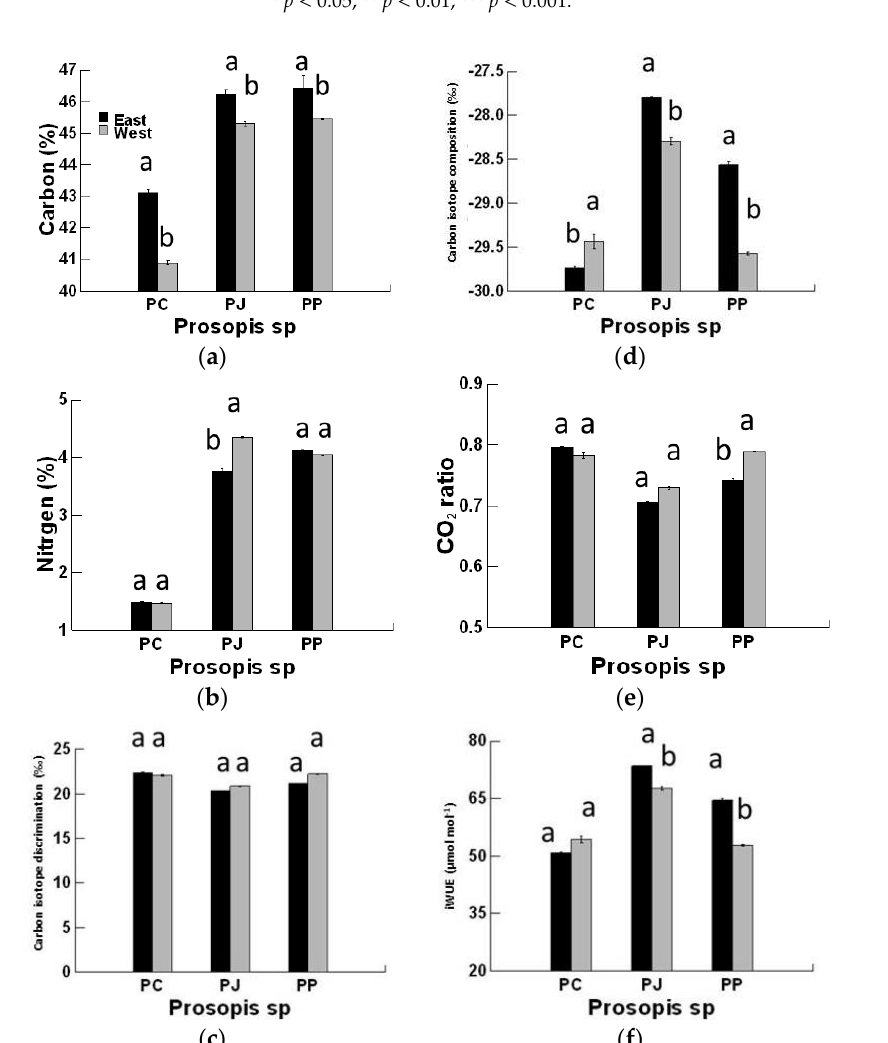
Figure 3. Effects of Prosopis species ( Prosopis juliflora , Prosopis pallida , and Prosopis cineraria ) canopy position (east and west) on ( a ) carbon (%), ( b ) nitrogen (%), ( c ) carbon isotope composition (‰), ( d ) carbon isotope discrimination (‰), ( e ) C i/ C a ratio, and ( f ) intrinsic water-use efficiency of young leaves of three species in the non-saline habitat.